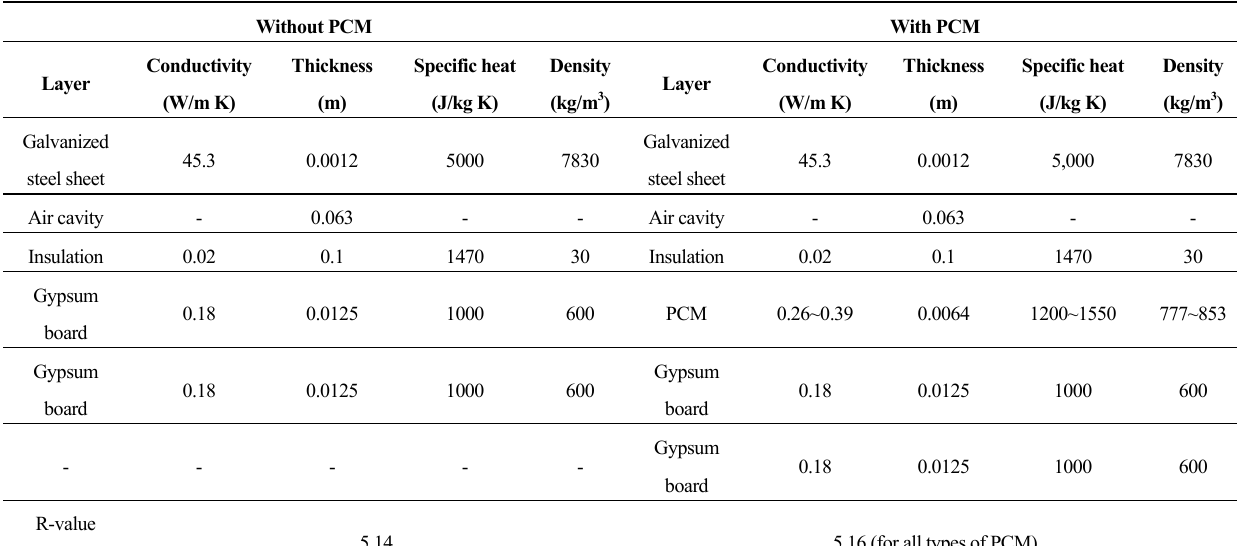
Table 3. Material properties and R-value of the exterior